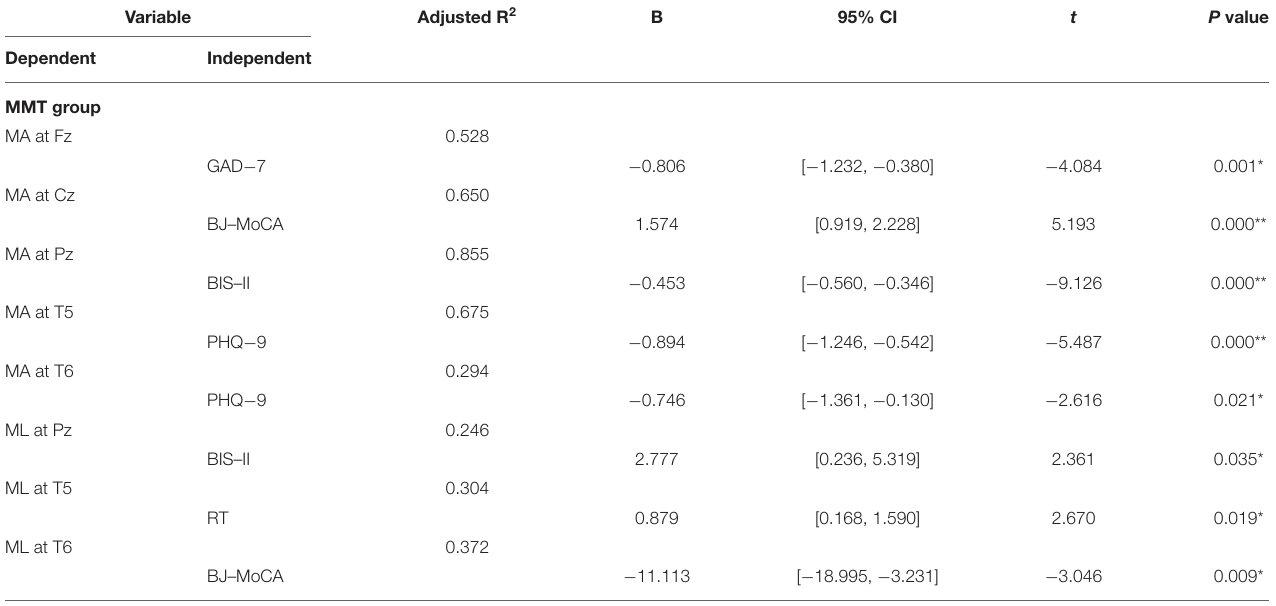
TABLE 4 | Stepwise regression model results for mean amplitude and mean latency of the MMT